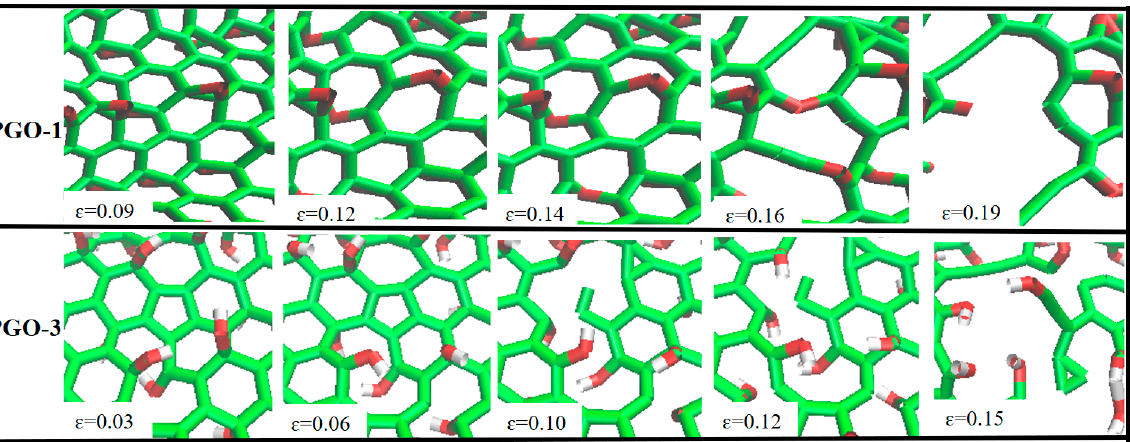
Figure 10. Fracture and reconstruction of the bonds between PGO-1 and PGO-3.